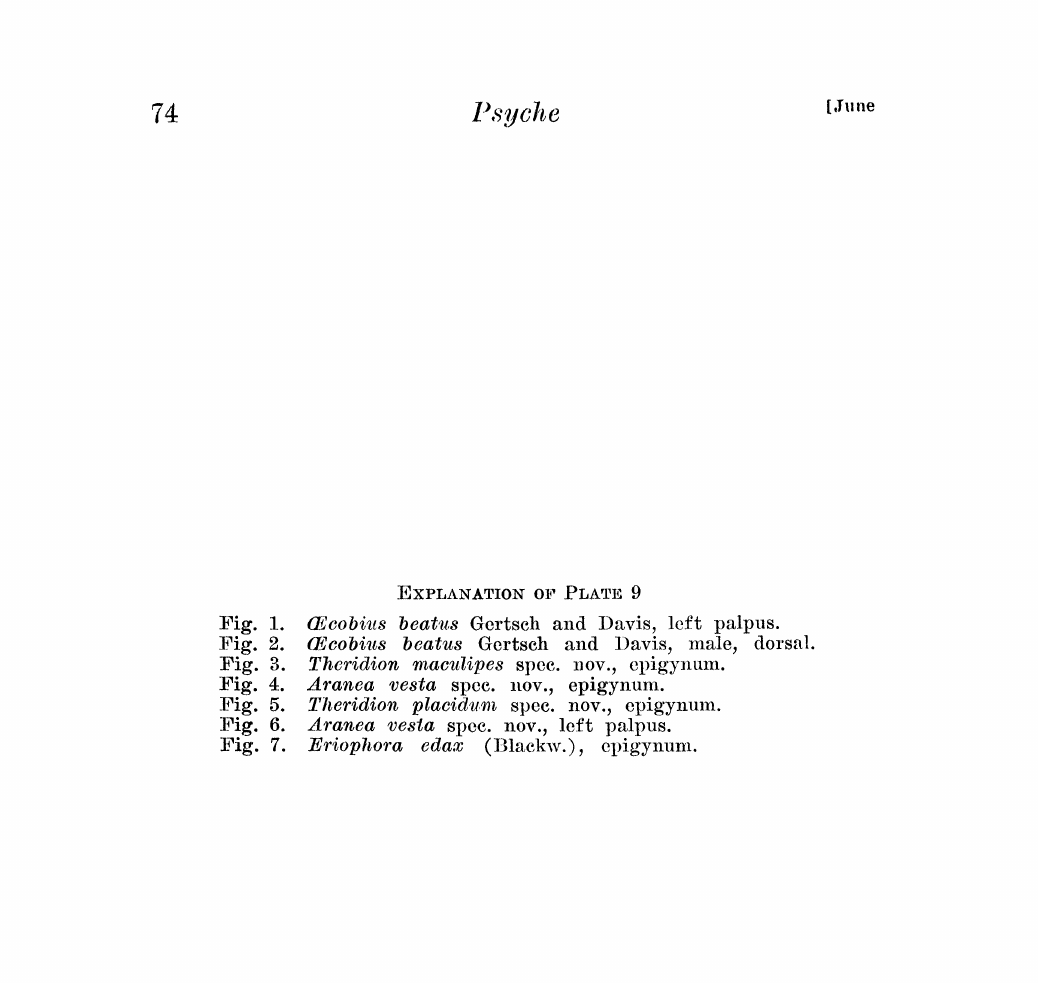
Fig. 1. (Ecobius beatus Gcrtsch and Dvis, left palpus. Fig. 2. (73cobius beatus Gcrtsch and ]_)avis, male, dorsal. Fig. 3. Thcridion maculipes spcc. nov., cpigynum. ]ig. 4. Aranea vesta spcc. nov., epigynum. Fig. 5. Theridion placidum spec. nov., cpigynum. Fig. 6. Aranea vesta spcc. nov., left palpus. Fig. 7. Eriophora edax (Blackw.),